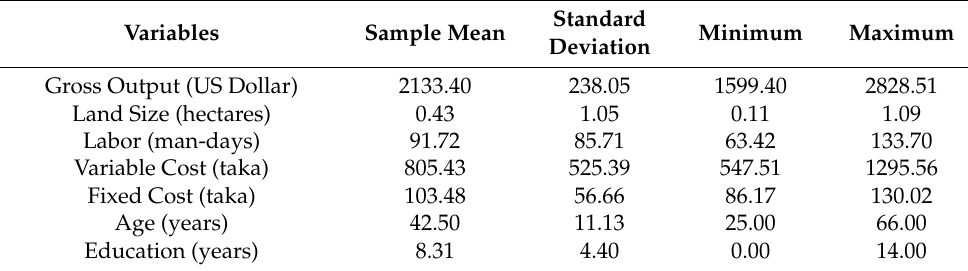
Table 11. Summary statistics for survey variables under different sweet potato